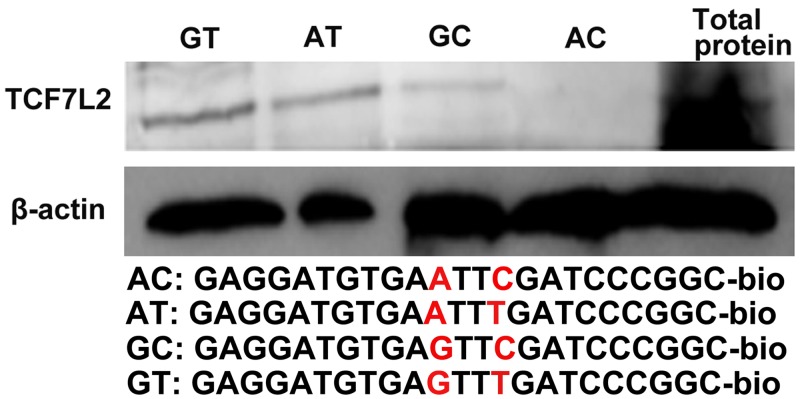
DNA pull-down results showing the interaction of TCF7L2 with the four haplotypes in 3T3-L1 cell in vivo.3T3-L1 cells were seeded in 10-cm dishes for 48 h, harvested and pull-downed by antibodies. Lane GT, AT, GC, and AC: immunoprecipitation results with anti-TCF7L2 monoclonal antibody. Lane total protein: the analysis of total cell lysates before immunoprecipitation to verify expression of TCF7L2. The sequences of four probes were shown under the panel.